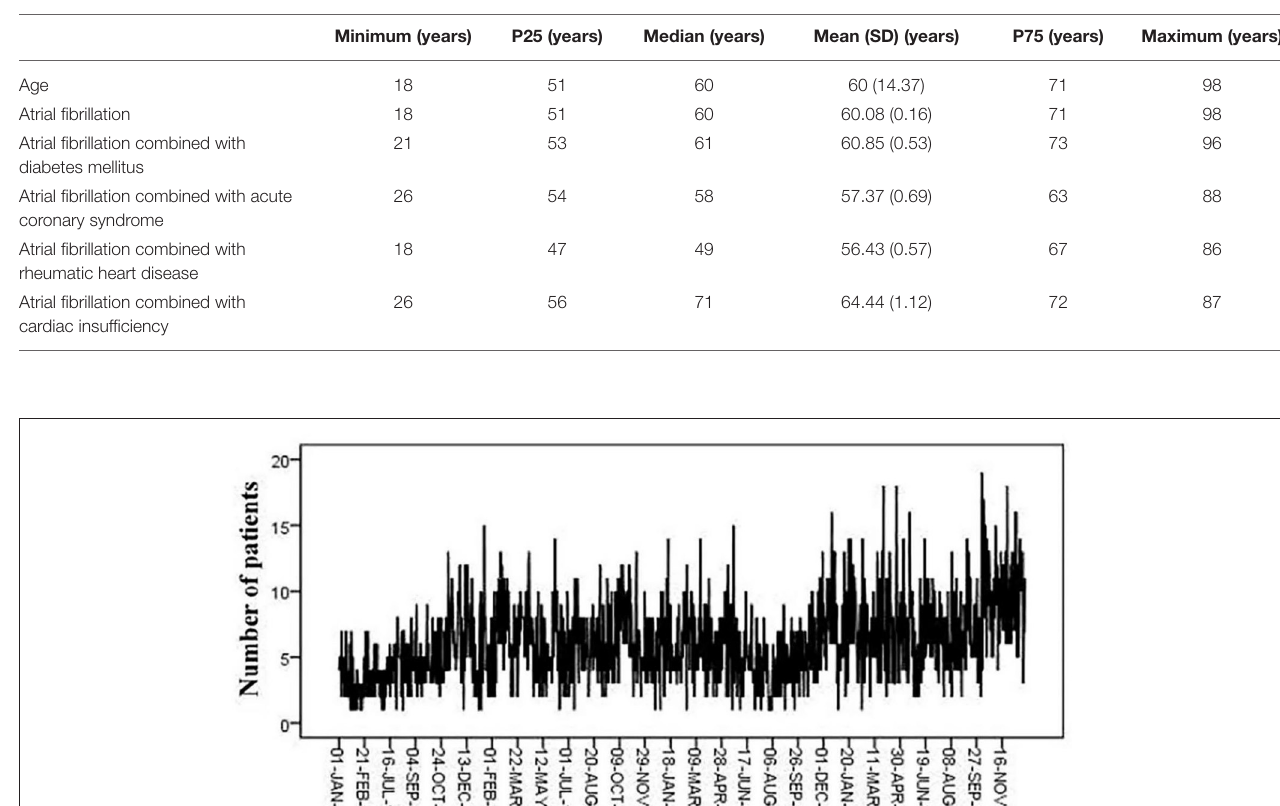
research evidence in China that air pollutant PM2.5 affected the clinical outcomes of CVD